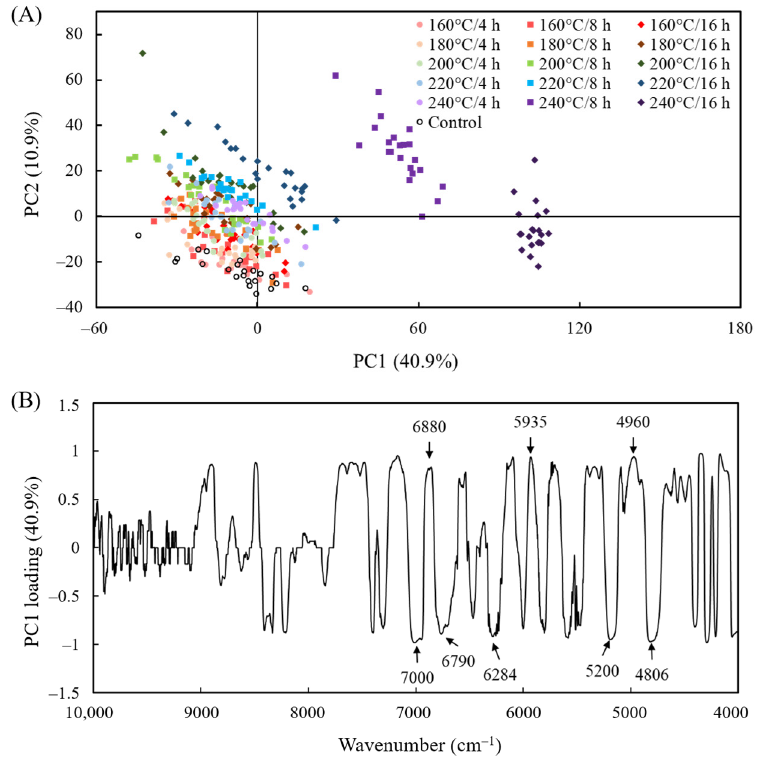
Figure 4. PCA scatter plot for the ( A ) NIR spectrum and ( B ) variable loading of PC1 for untreated and VH-treated luanta fir wood.